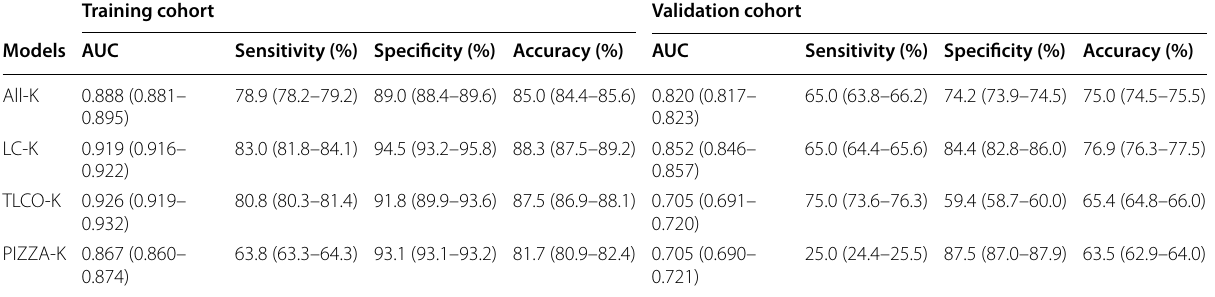
Data in parentheses are 95% confidence interval